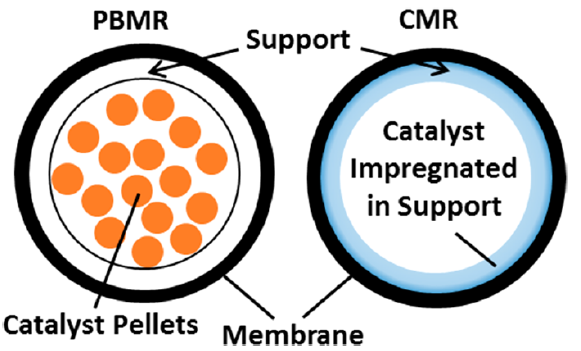
Figure 16. Comparison of cross-sections between a PBMR and a CMR [60].